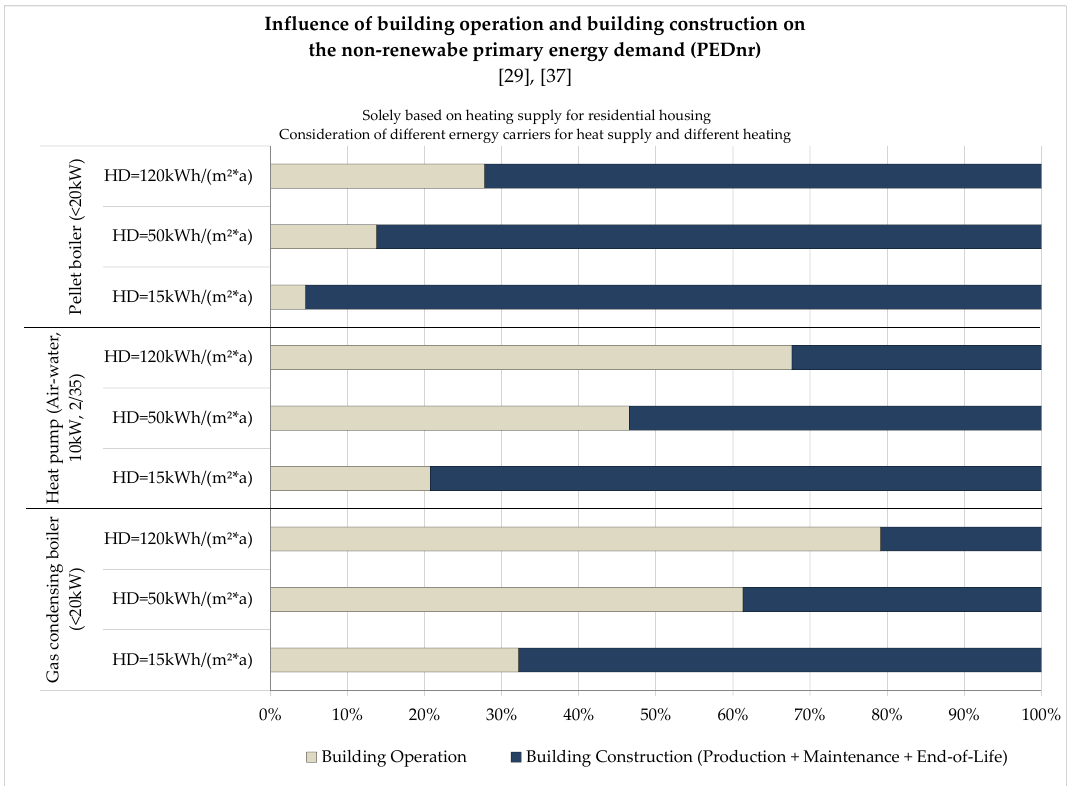
Figure 1. Influence of building operation and building construction on the non-renewable primary energy demand (PEDnr), solely based on heating supply for residential housing, different energy carriers (gas, district heat, wood pellets), and different heating energy demands (own depiction referring to